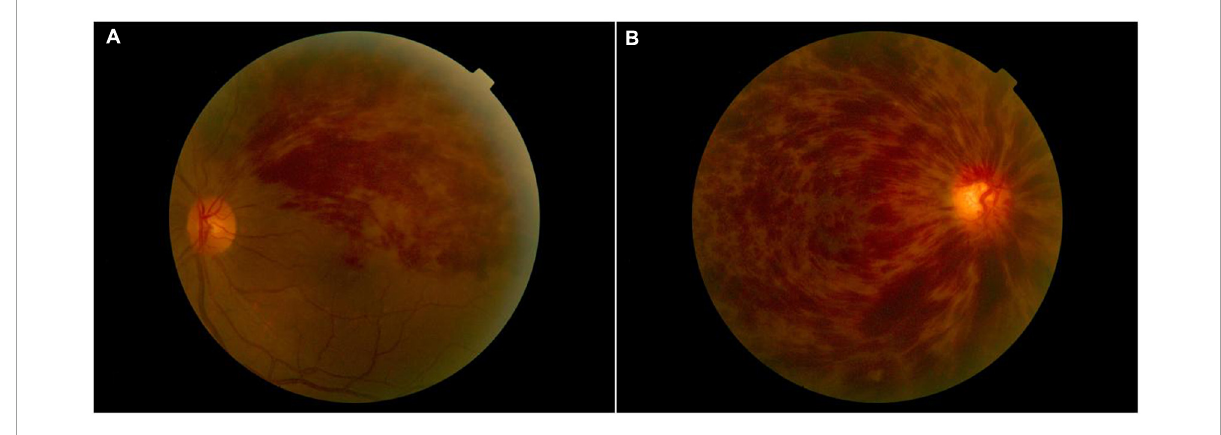
FIGURE1 A typical fundus photograph of BRVO (A) and CRVO (B) . BRVO, branch retinal vein occlusion; CRVO, central retinal vein occlusion.